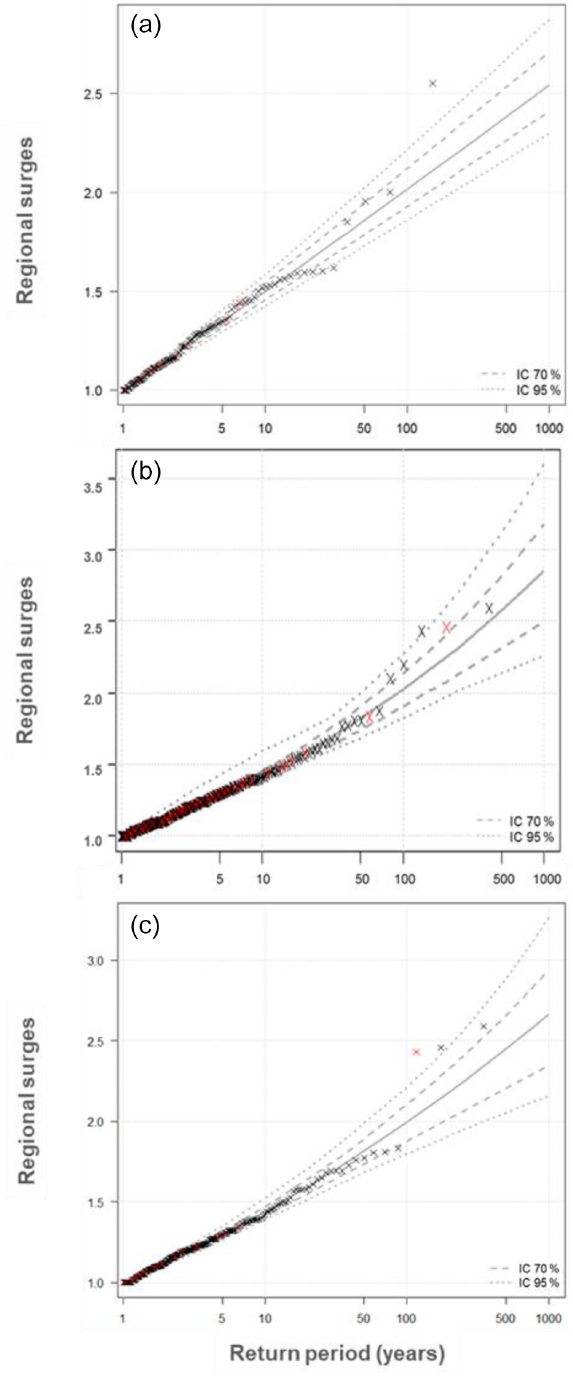
Figure 6. The GPD–sinusoid fitted to regional SSSs (plotting positions, RLs, and confidence intervals) for the target sites: Exp sin distribution for Calais (a) and GPD cos sin for Brest (b) and La Rochelle (c) . The y axis represents the normalized regional surges (without unit); the x axis represents the return period (in years). The red crosses indicate the SSSs at the target site, so the black crosses indicate the regional ones. The confidence intervals at 70% (dashed line) and 95% (dotted line), which are computed by the bootstrap method, are also presented (dotted